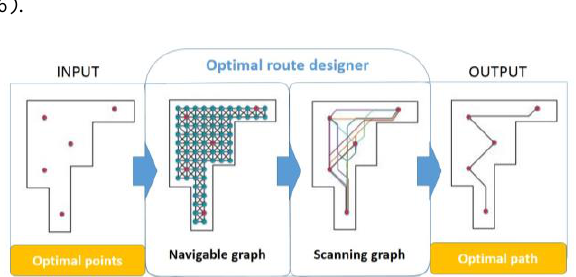
Figure 6. Workflow summarizing the steps towards route optimization.